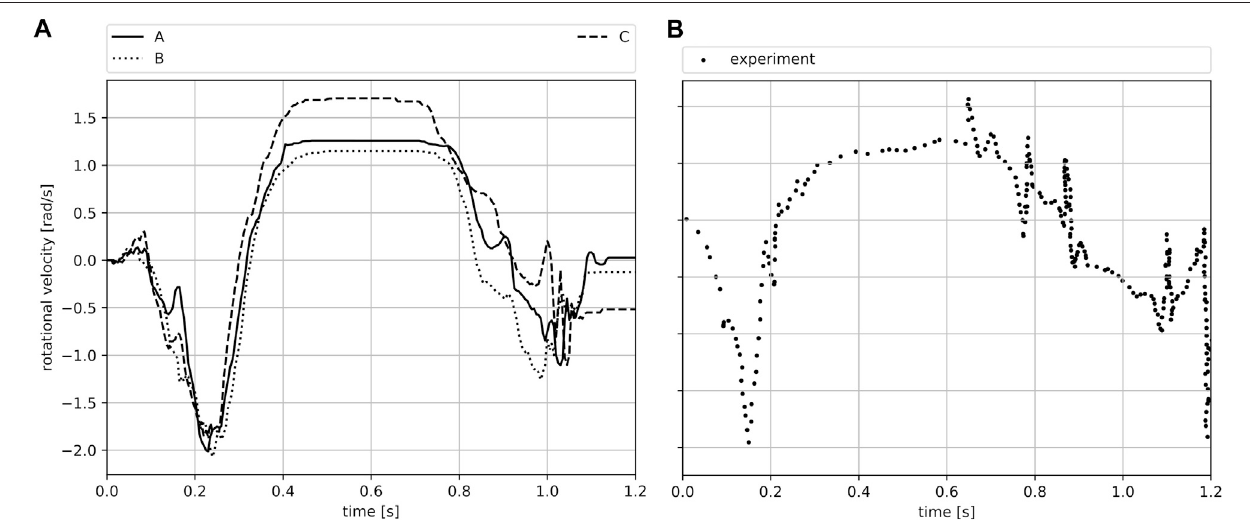
FIGURE 14 | Visualization of angular velocity about one of the main axis of the impacting object T092. (A) Simulation. (B) General trend from experiment.